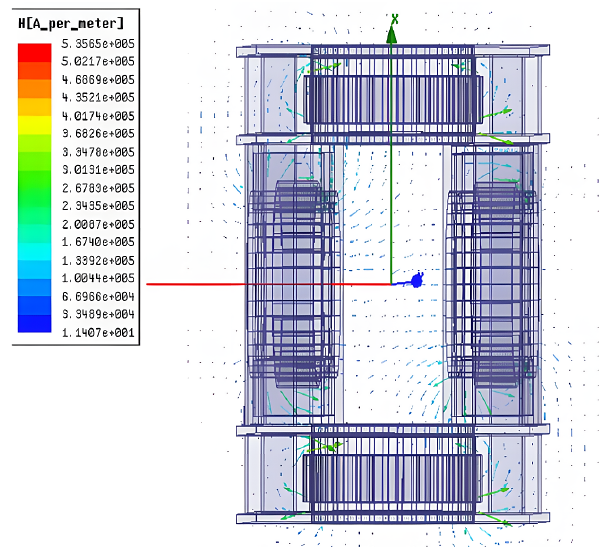
Figure 14. Magnetization drive coil X-Y plane magnetic induction line distribution.